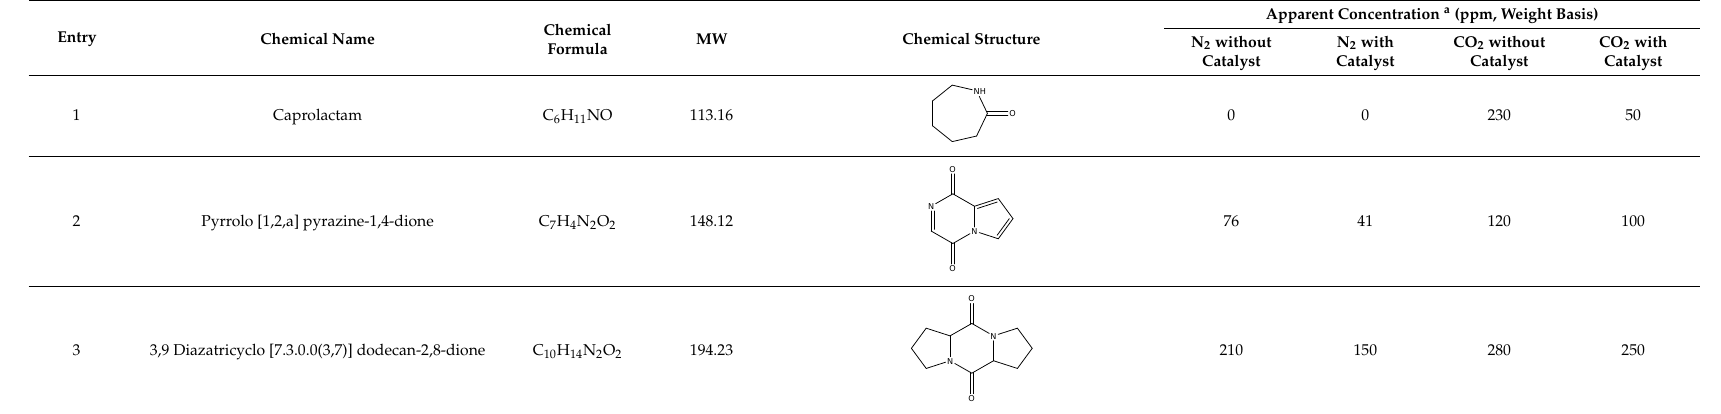
Table 4. Chemical compounds that do not have a benzene ring identified in the pyrolytic products generated from the pyrolysis of the herbal medicine waste and their concentrations obtained from four different pyrolysis experiments. Mean values of replicates ( n = 3) are reported and standard deviations of the mean values of around 7%.